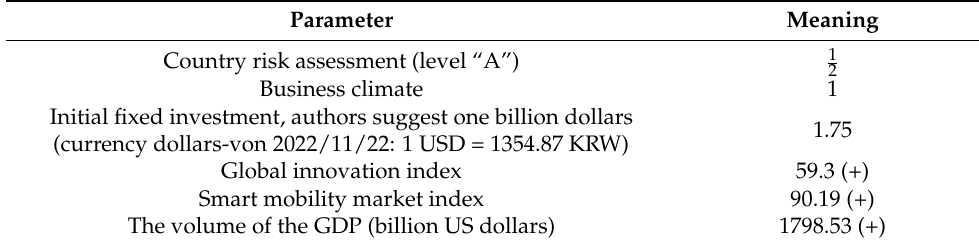
Table 4. Model parameters for South Korea.